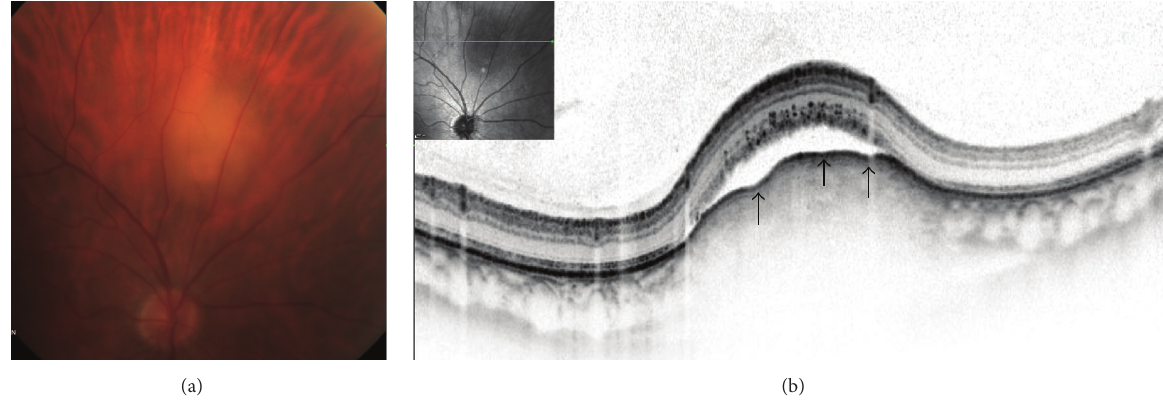
Figure 5: Right eye choroidal metastasis in a patient with esophageal carcinoma. The amelanotic choroidal metastasis is demonstrated superior to the optic disc (a). Horizontal OCT scan (b) at the center of the tumor showing lobularity of the anterior choroidal surface (arrows). There is subretinal fluid and structural loss of the internal/outer segment junction with shaggy photoreceptors.